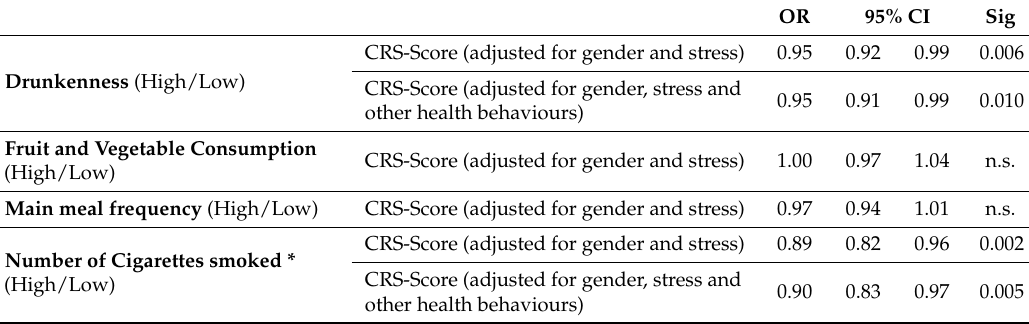
Table 4. Logistic regression models for the association between religiosity and health